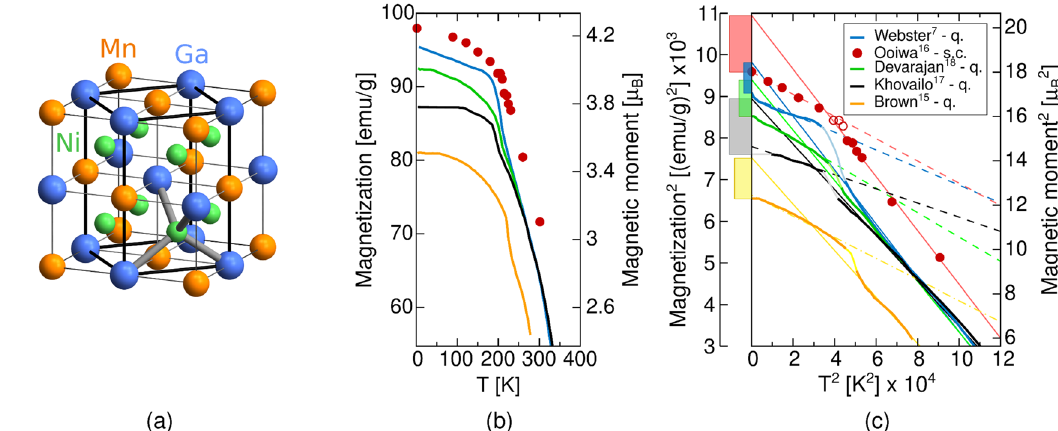
Figure 1. Depiction of ( a ) conventional L2 1 austenite unit cell with 8-atom computational cell highlighted, ( b ) experimentally measured magnetization saturation as a function of temperature, and ( c ) the same data represented in squared coordinates with extrapolation of linear sections to 0 K (solid line for austenite and dash line for martensite), following Ref. 16 . The legend includes abbreviations q. and s.c. to denote quenched